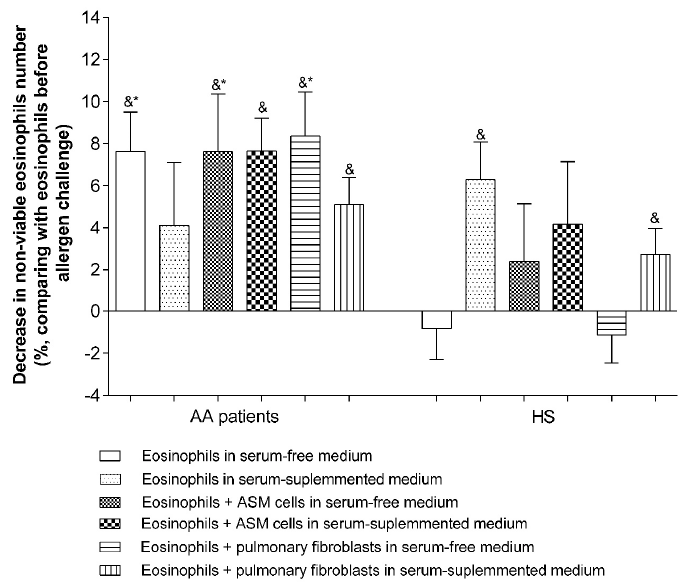
Figure 9. The bronchial allergen challenge effect on the number of non-viable eosinophils. Results from independent experiments of AA— n = 11, HS— n = 11; AA—Allergic asthma, HS—Healthy subjects. * p < 0.05 compared with the viability of the healthy eosinophil group; & p < 0.05 compared with the viability of eosinophils before the bronchial challenge. Added blood serum—2% of v / v . Statistical analysis: between investigated groups—Mann–Whitney two-sided U-test; within one study group—Wilcoxon matched-pairs signed-rank two-sided test. Moreover, we evaluated in vivo the effect of activated AA and HS eosinophils on structural cell proliferation. We observed that eosinophils’ pro-proliferative effect on ASM cells after a bronchial allergen challenge was enhanced by 11.6% ± 8.7% in the AA group and by 9.8% ± 4.1% in the HS group, compared with the effect of non-activated eosinophils. An enhanced pro-proliferative effect on pulmonary fibroblasts was only observed in the AA group (enhanced by 7.2% ± 2.5%), compared with the effect of non-activated eosinophils (Figure 10).